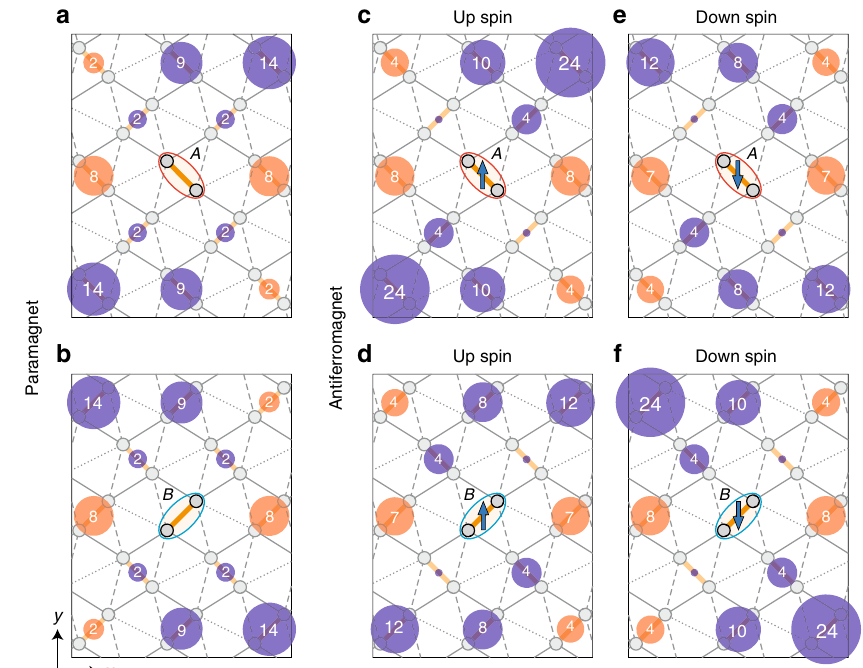
Fig. 3 Spatial anisotropy of inter-dimer transfer integrals. a , b Effective transfer integrals between the central dimer ( A in a and B in b ) and the surrounding ones, obtained from the second-order perturbation processes with respect to the bonding-antibonding orbital hybridizations, in the PM phase. c – f Effective transfer integrals calculated likewise for up- ( c , d ) and down-spin ( e , f ) electrons in the AFM phase (the local magnetic moment is about 0 : 168 _ ). The areas of the red (blue) shaded circles represent the amplitudes of positive (negative) transfer integrals. The amplitudes are shown in the circles in unit of